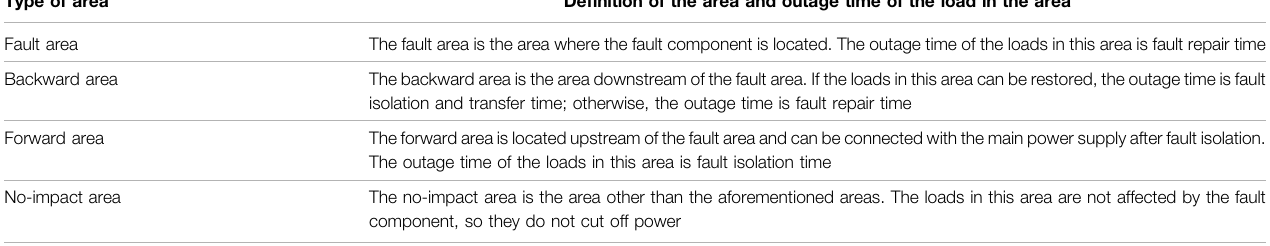
TABLE 1 | De fi nition of the four types of areas. Type of area